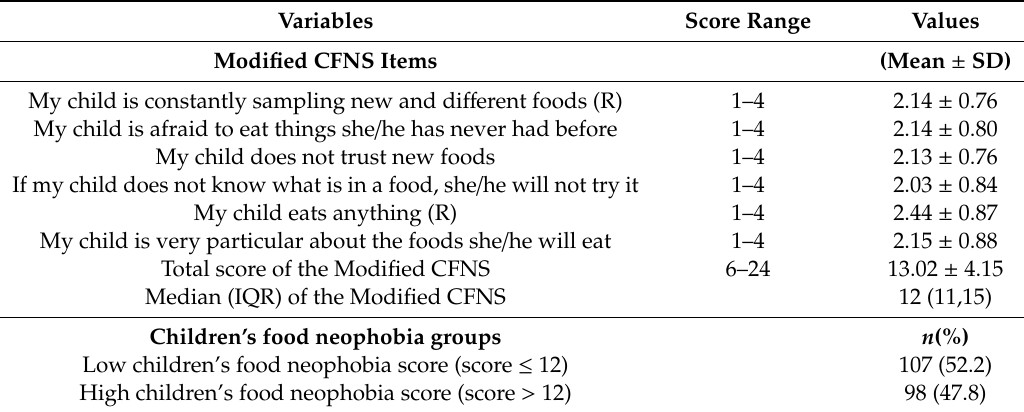
Table 1. Assessment of children’s food neophobia ( n =